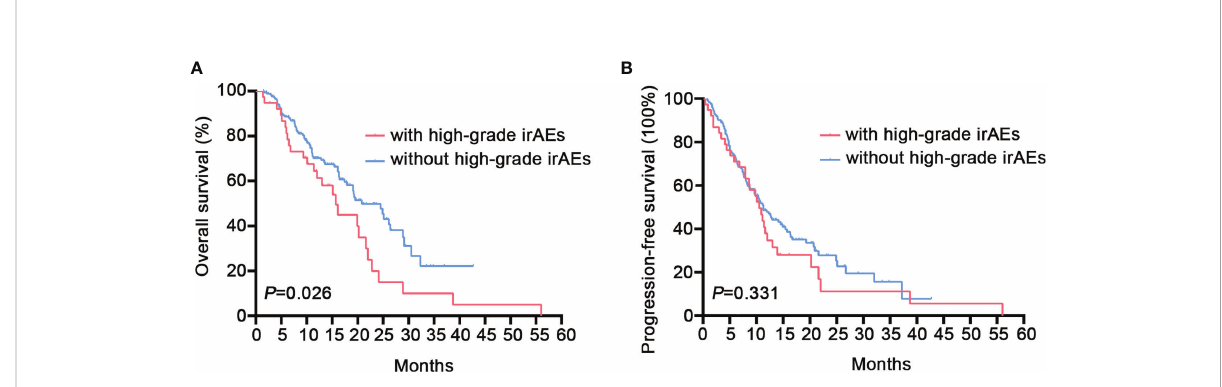
FIGURE 2 Overall Survival (OS) and progression-free survival (PFS) of patients with high-grade immune-related adverse events (irAEs). (A) The median OS was 15.7 (95% CI: 11.6-19.8) months for patients with high-grade irAEs vs. 20.8 (95% CI: 16.0-25.5) months for patients without high-grade irAEs (P=0.026). (B) The median PFS was 10.5 (95%CI: 8.8-12.3) months for patients with high-grade irAEs vs. 11.3 (95%CI: 9.0-13.6) months for patients without high-grade irAEs